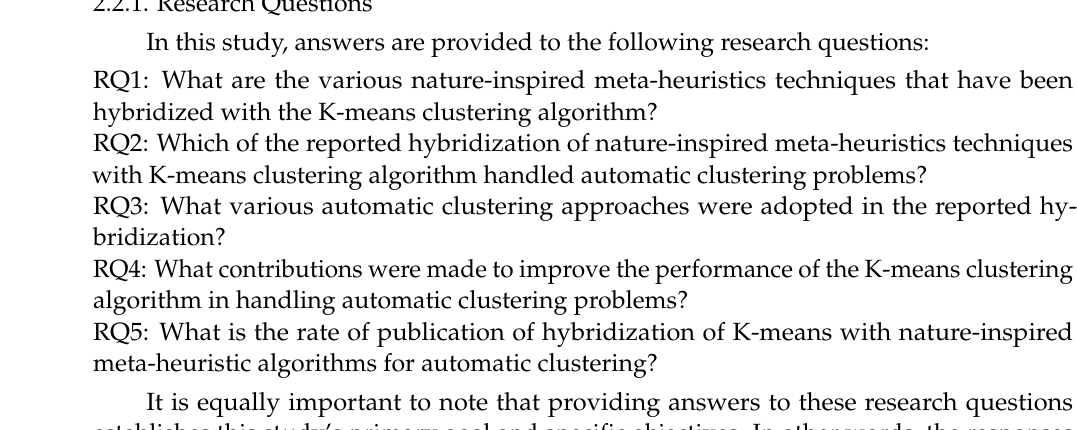
Figure 1. Adopted review of research methodology.